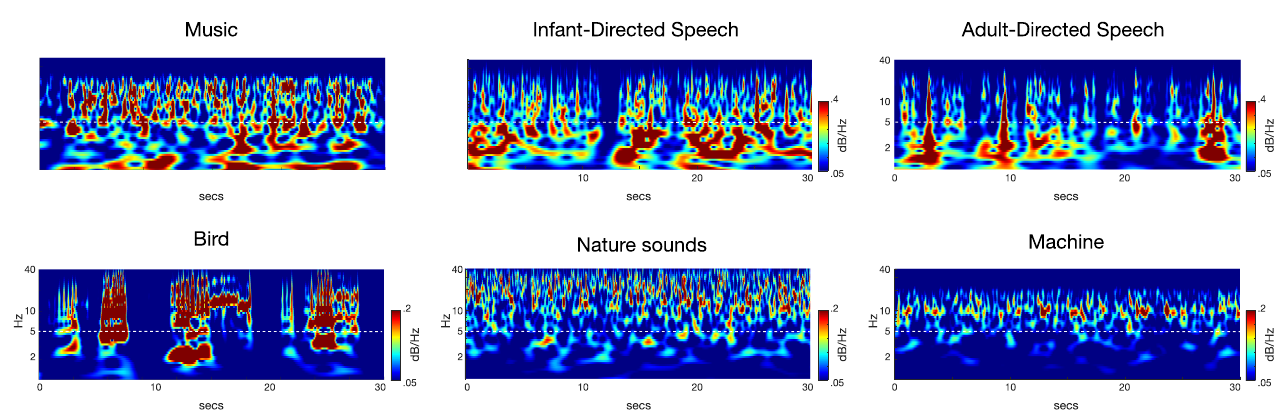
Fig 1. Scalograms depicting the amplitude modulation (AM) envelopes derived by recursive application of PAD. We depict music (classical), IDS (naturalistic conversation), ADS (naturalistic conversation, [75]), bird song (nightingale), nature sounds (averaged) and a man-made rhythmic sound (a machine) using Continuous Wavelet Transform (CWT), which was run on each AM envelope from randomly chosen 30-s excerpts of music, IDS, ADS, bird song, nature sounds, and machine sounds. Note that similar scalograms cannot be generated for S-AMPH because of the use of cochlear filterbanks, which means that boundary frequencies would disappear. The x-axis denotes time (30 s) and the y-axis denotes modulation rate (0.1-40Hz). The maximal amplitude is normalized to 0 dB. The demodulation outputs are shown as a heat map. It should be noted the low frequency structure ( < 5 Hz) visible in music and IDS is absent for the nature and machine sounds and weak for ADS and bird song. That is, systematic patches of red can be seen recurring at low frequencies for speech and music (~2 Hz and ~5 Hz), but not for nature sounds or mechanical sounds. Comparison of the temporal structures of these sounds for the low-frequency modulation rates (0–5 Hz) shows that only music and speech show strong delta- and theta-AM band patterning. The nested structure of AM patterning across the higher modulation bands (12-40Hz) is also clearly visible for the quasi-rhythmic sounds found in nature. This patterning is clearly absent for the man-made rhythmic sound of a